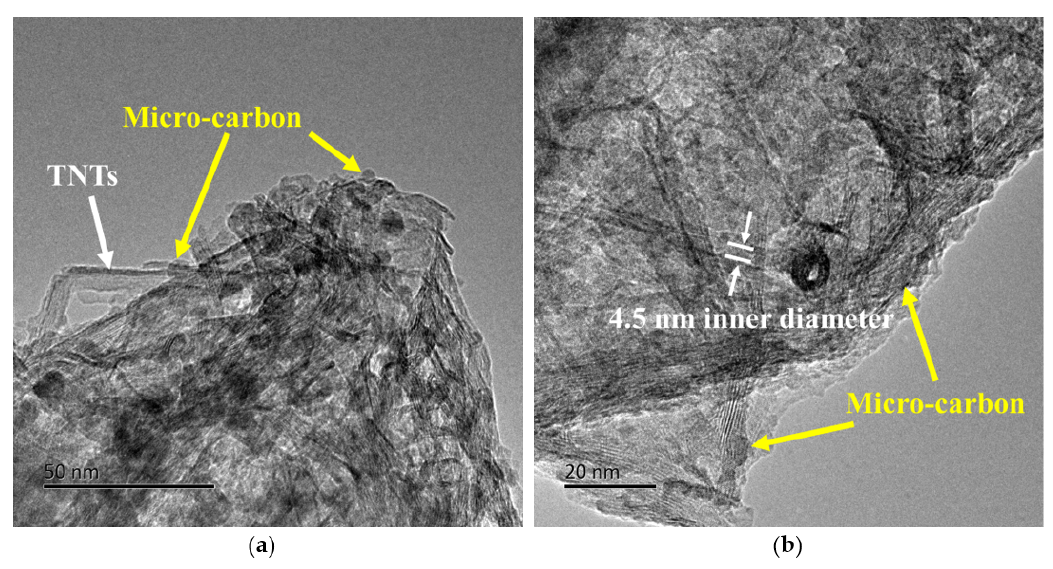
Figure 1. HRTEM (high-resolution transmission electron microscopy) images of TNTs@AC (activated charcoal supported titanate nanotubes), 50 nm ( a ) and 20 nm ( b ).